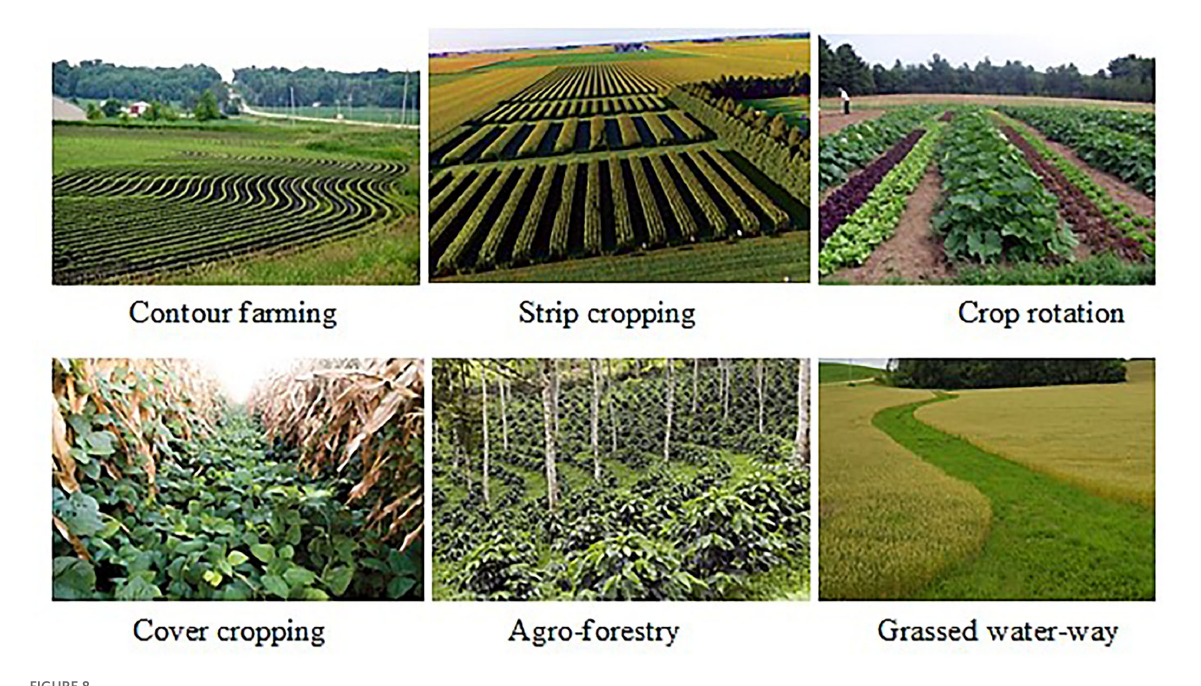
FIGURE8 Images of conservative cropping systems. Source: google images.